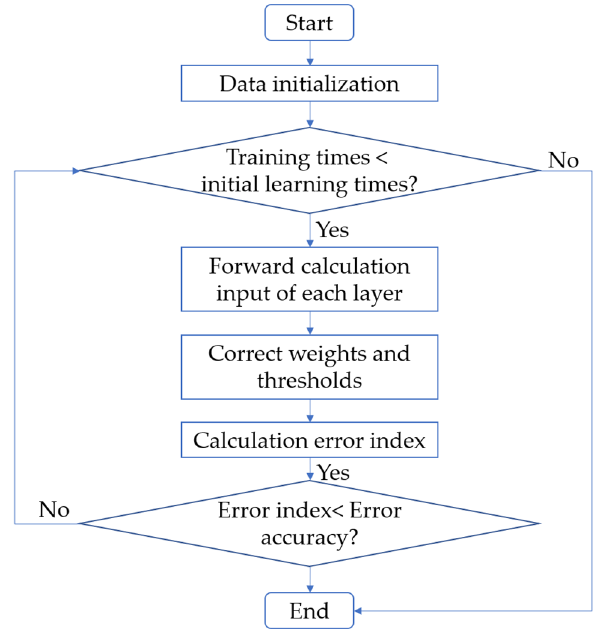
Figure 3. Flow chart of BPNN.